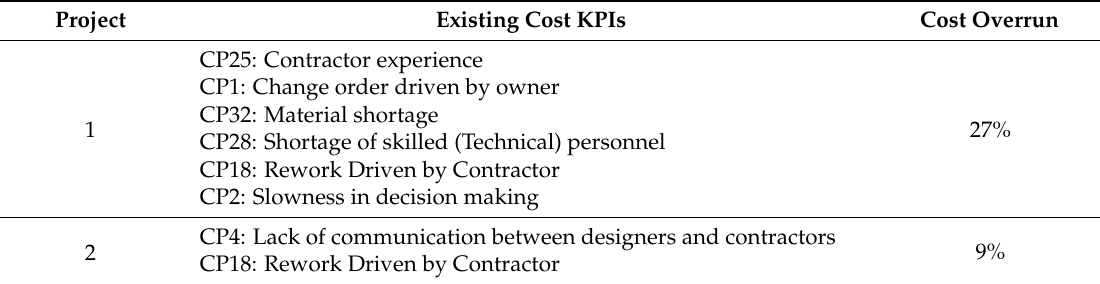
Table 10. Information for case study projects for implementation of